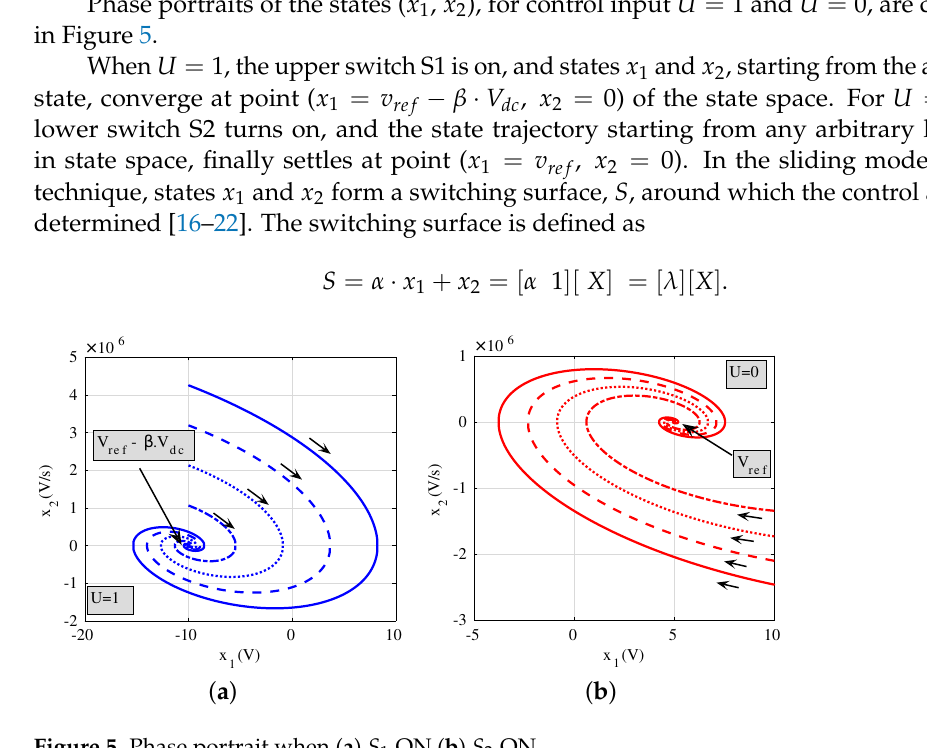
Figure 5. Phase portrait when ( a ) S 1 ON ( b ) S 2 ON. The coefficient α in (7) is termed as a sliding coefficient. The coefficient α , a control parameter, is chosen to determine the slope of the error trajectory, e ( t ) . Figure 6 depicts a sliding line, which is obtained by setting S = 0. The line α · x 1 + x 2 = 0 bisects the entire phase plane, depicted in Figure 6.